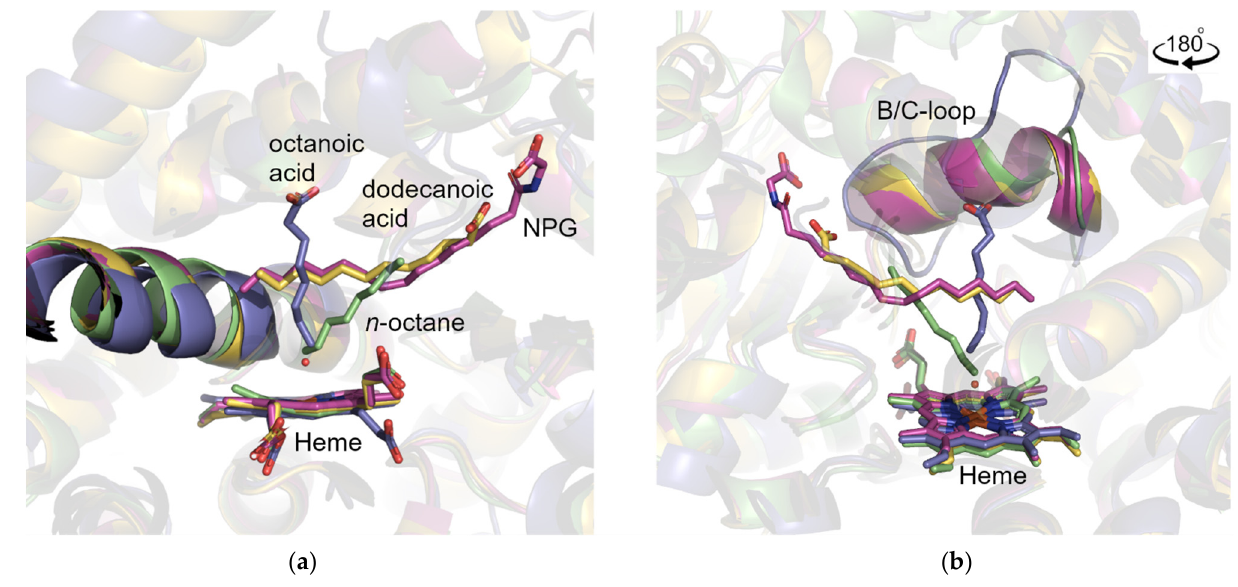
Figure 9. ( a ) Substrate binding relative to I ‐ helix and heme by CYP153A71 (blue, octanoic acid), CYP4B1 (green, n ‐ octane, 5T6Q), CYP102A1 (pink, N ‐ palmitoylglycine, 3CBD), and CYP505A30 (yellow, dodecanoic acid, 7P6L); ( b ) substrate binding (rotated 180 °C) relative to B/C loop.